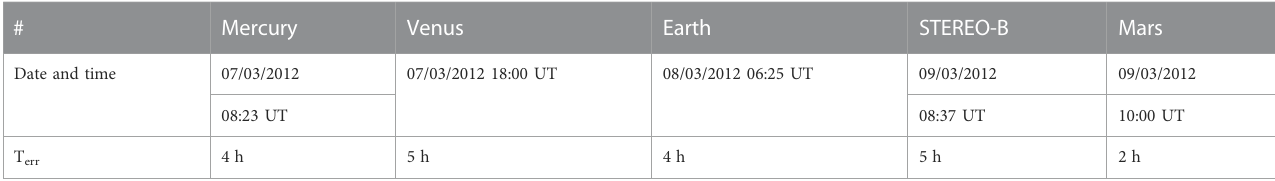
TABLE 1 Calculated hit time of shock by the WSA-ENLIL + Cone model at various locations in the inner Solar System along with the prediction error compared to the observed shock arrival time. # Mercury Venus Earth STEREO-B